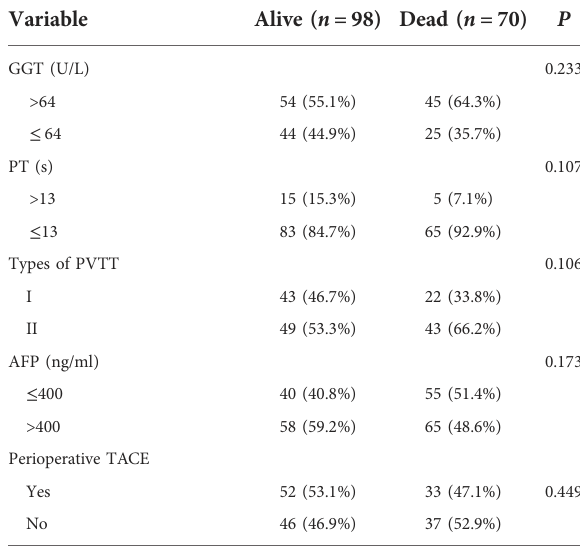
BDTT, bile duct tumor thrombus; T-Bil, total bilirubin; ALT, alanine aminotransferase; GGT, γ -glutamyltransferase; PT, prothrombin; AFP, alpha- fetoprotein; TACE, transarterial